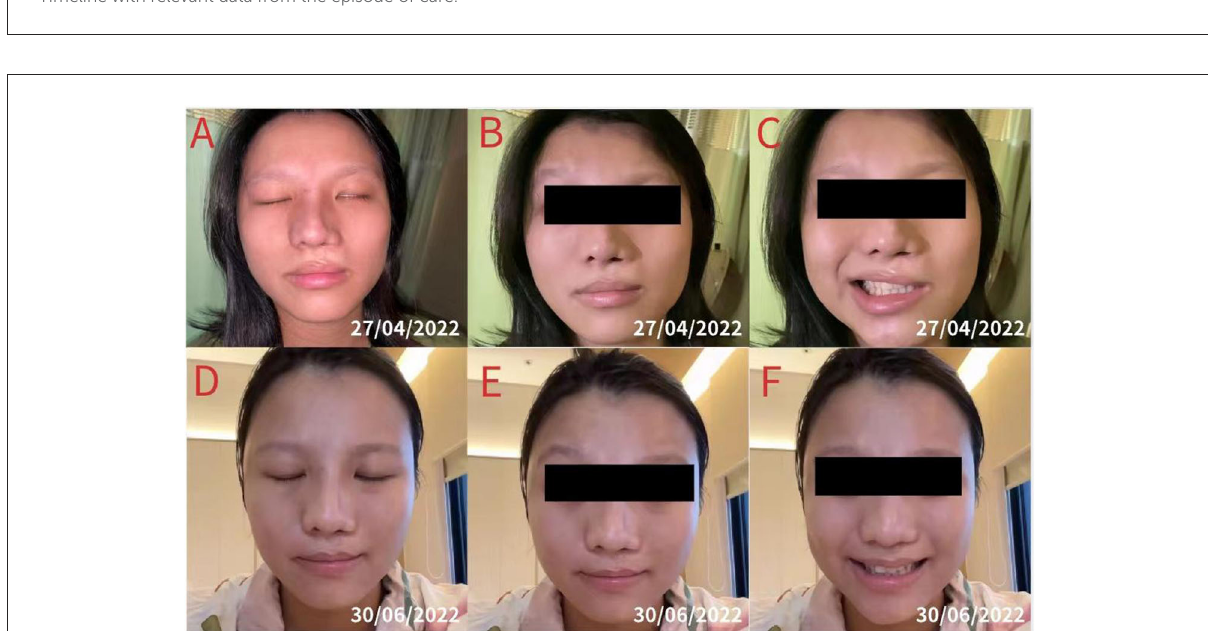
FIGURE2 A patient with left-sided Bell’s palsy. (A) Incomplete closure of the left eye and disappearance of creases on the forehead. (B) Inability to lift the left eyebrow. (C) Asymmetrical smiling and shallow left nasolabial fold. The patient received five sessions of acupuncture treatment. (D) Symmetrical closure of the eye. (E) Forceful raising of the left eyebrow and evident creases on the forehead. (F) Symmetrical smiling and an obvious left nasolabial fold.